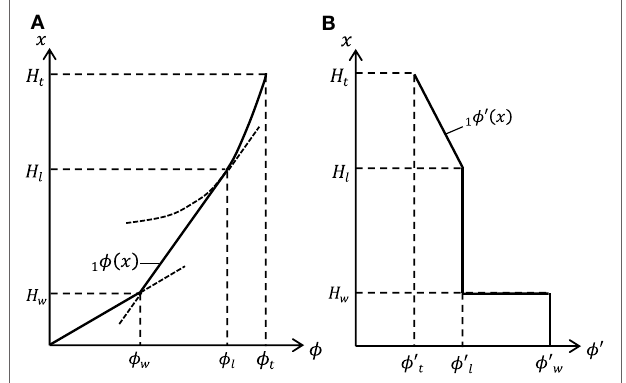
FIGURE 4 | Fundamental mode and its story drift angle: (A) fundamental mode shape and (B) story drift